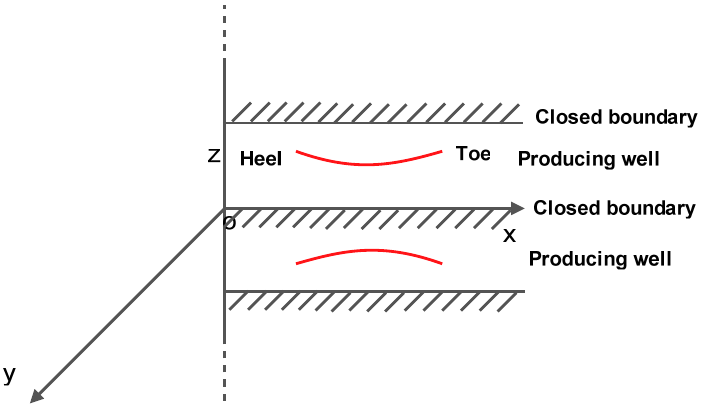
Figure 3. Mirror of horizontal well in upper and lower enclosed boundary reservoir.